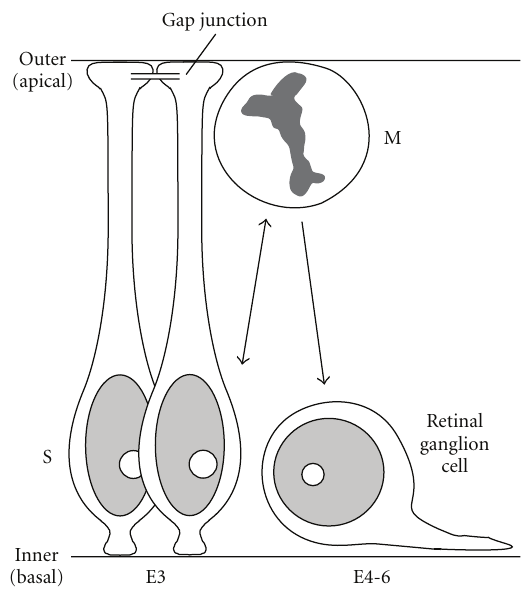
Figure 1: Schematic drawings of retinal neuroepithelial cells in cell cycle and the first di ff erentiated neuron, a retinal ganglion cell. In chick embryo, the retina is composed almost homogeneously of neuroepithelial cells on embryonic day 3 (E3). The retinal ganglion cells are born mainly at E4–6. S: S-phase; M: M-phase. The outer (apical) surface faces the space that is continuous with the ventricle. This figure is cited from [5].